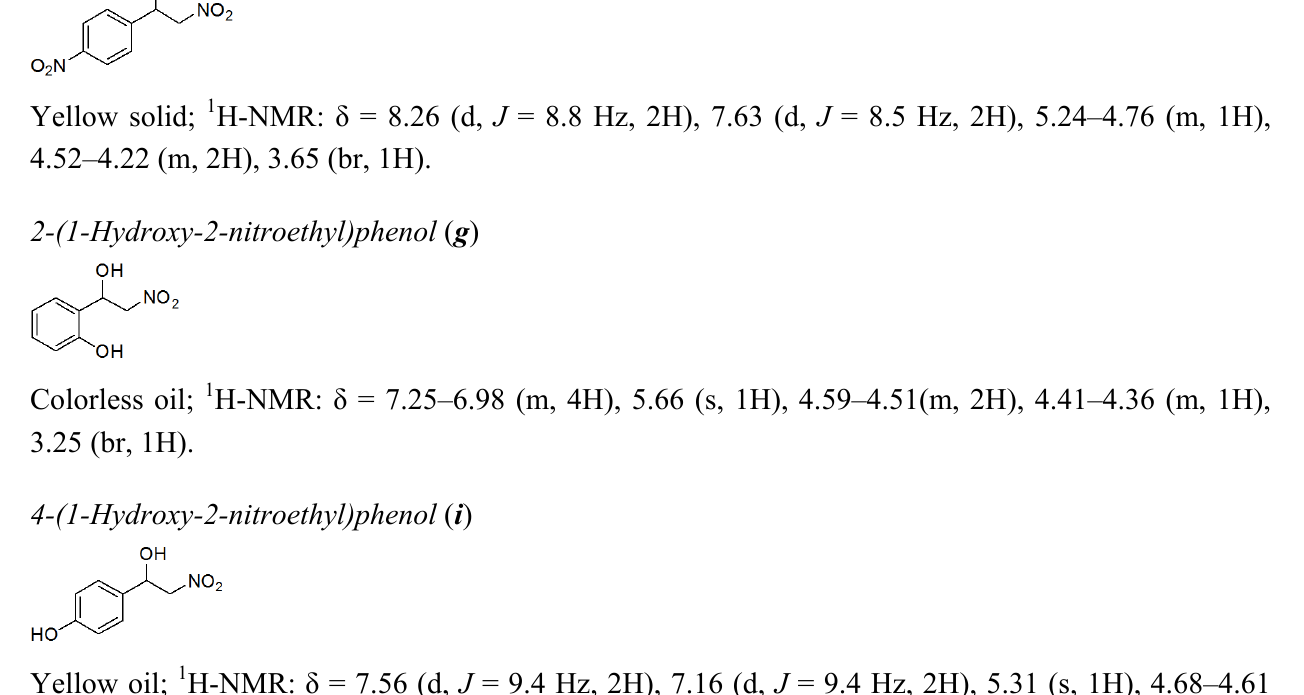
Yellow oil; 1 H-NMR: δ = 7.56 (d, J = 9.4 Hz, 2H), 7.16 (d, J = 9.4 Hz, 2H), 5.31 (s, 1H), 4.68–4.61 (m, 2H), 4.58–4.34 (m, 1H), 3.82 (br, 1H). 1-(3-Chlorophenyl)-2-nitroethanol ( k )